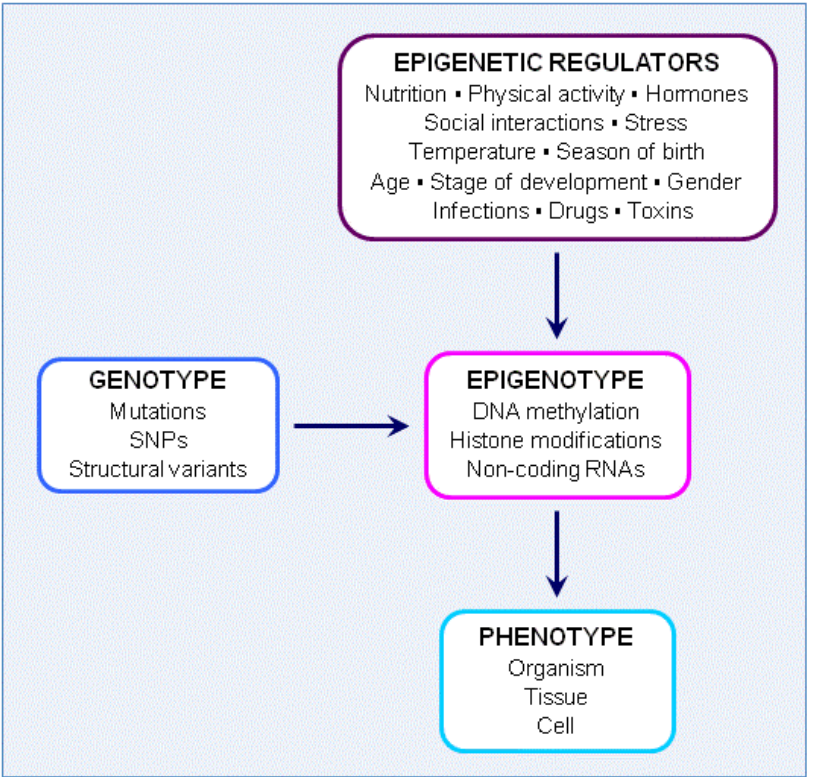
Figure 2. Interactions between genotype, epigenotype and